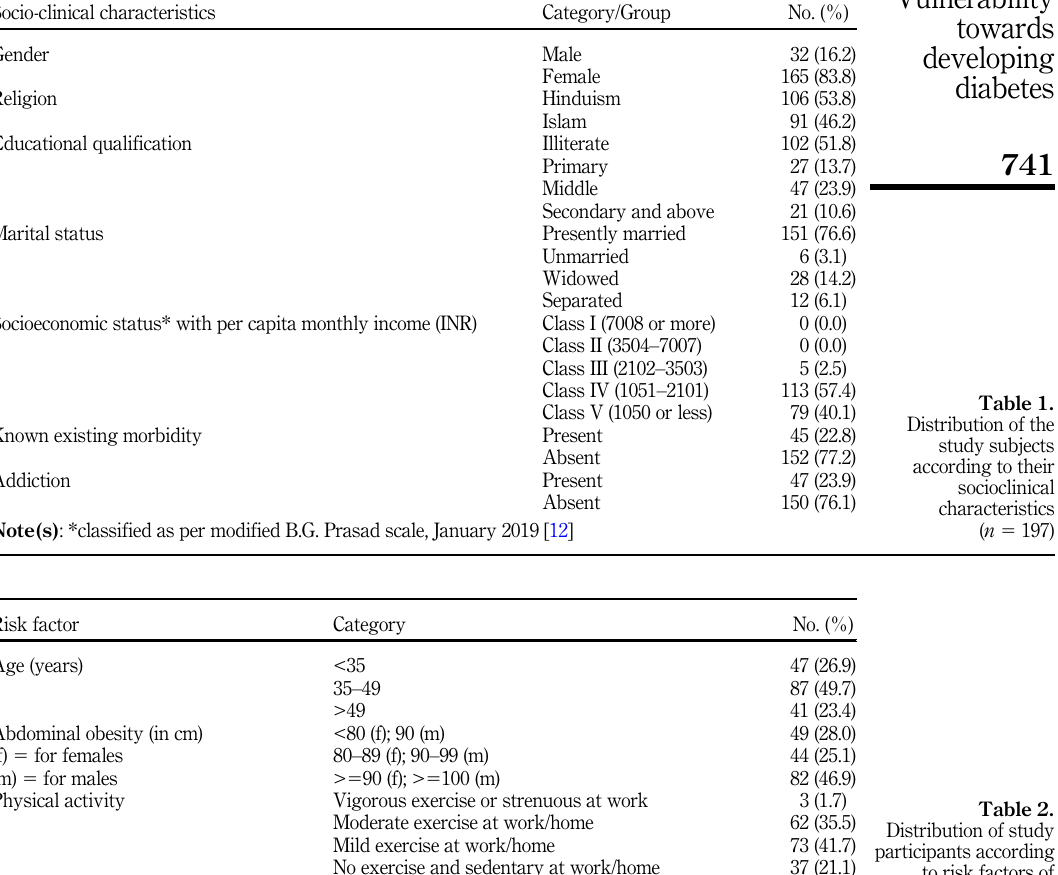
Table 2. Distribution of